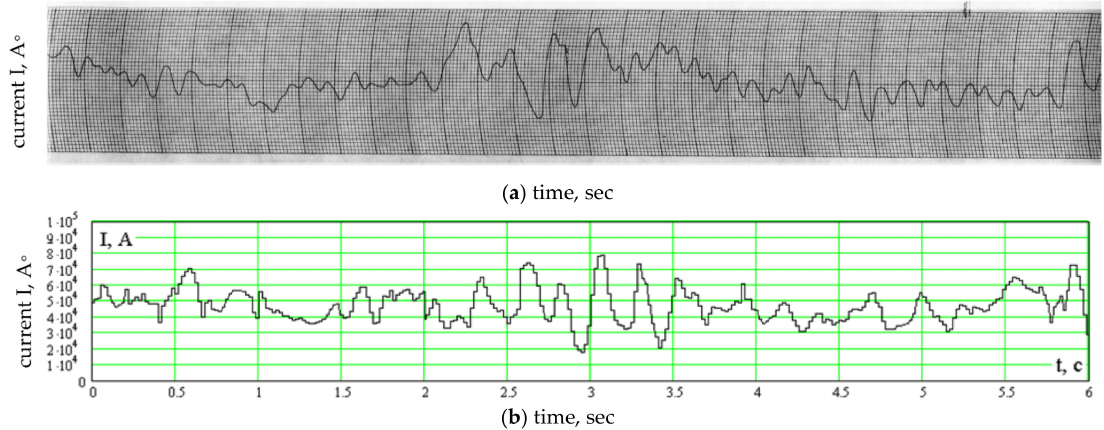
Figure 16. The dependences of the phase B current change for the stage of melting completion obtained experimentally ( a ) and using a model with tabular volt-ampere characteristics and the application of the 4-th order Runge-Kutta method ( b